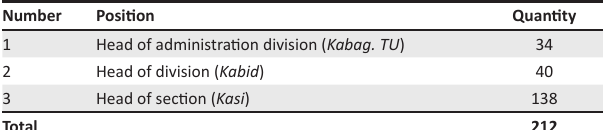
TABLE 1: Distribution of respondents based on position. Number Position